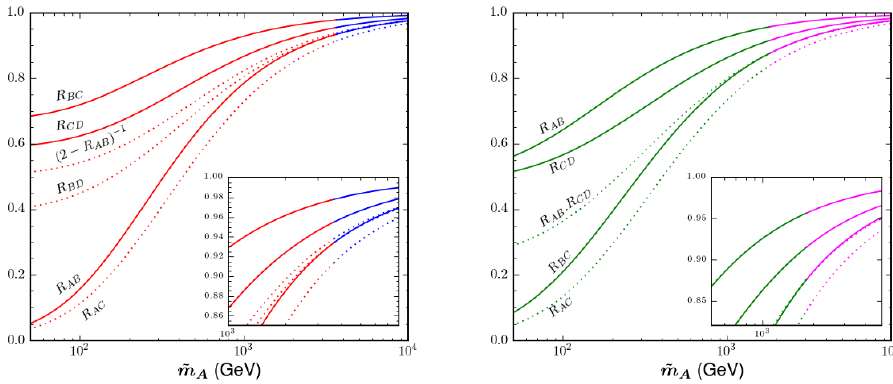
Figure 5 . The equivalent representation of (cid:12)gure 4 in terms of the mass squared ratios R R BC and R CD (solid lines). The dotted lines depict various quantities of interest which are used to delineate the regions in (cid:12)gure 2. The left panel shows the true branch passing through regions (3 ; 1) (red) and (4 ; 1) (blue), while the right panel shows the auxiliary branch through regions (2 ; 3) (green) and (4 ; 3) (magenta). The left insert zooms in on the transition between regions (3 ; 1) and (4 ; 1) near ~ m A = 3600 GeV, while the right insert focuses on the transition between regions (2 ; 3) and (4 ; 3) near ~ m A = 1800